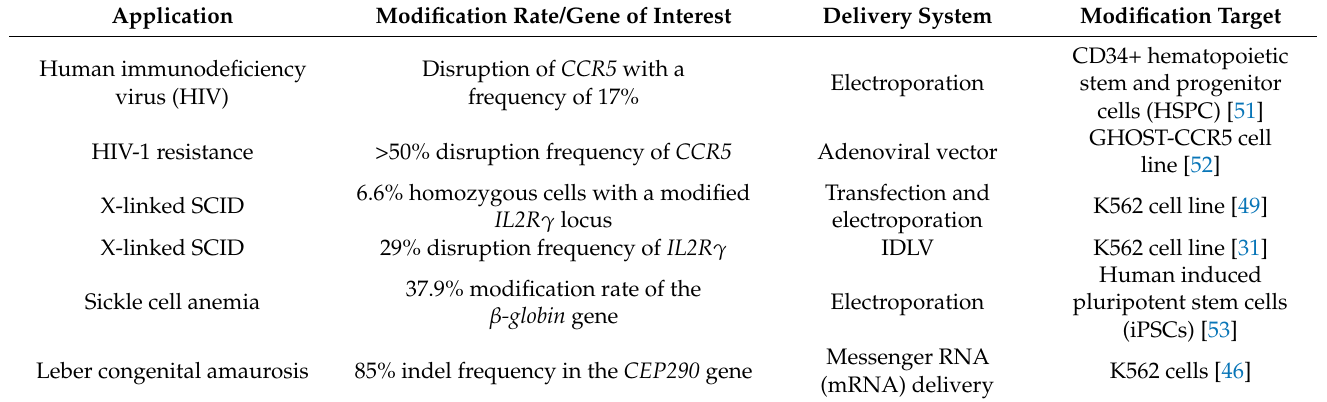
Table 3. Modification rates obtained using ZFNs in clinically relevant